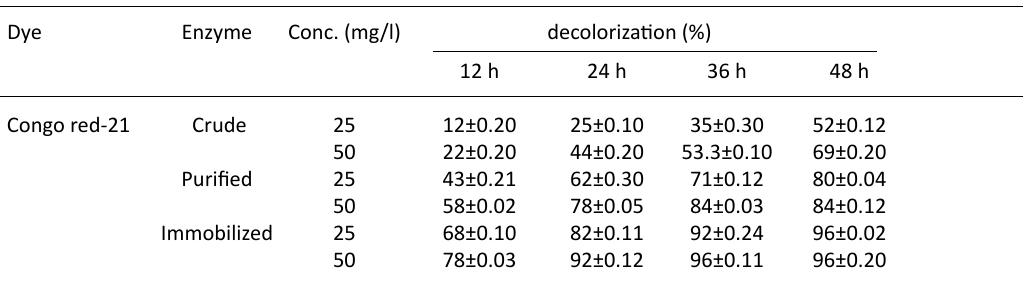
Table 2. Congo Red-21 Decolorization by Laccase Dye Enzyme Conc. (mg/l) decolorization (%)